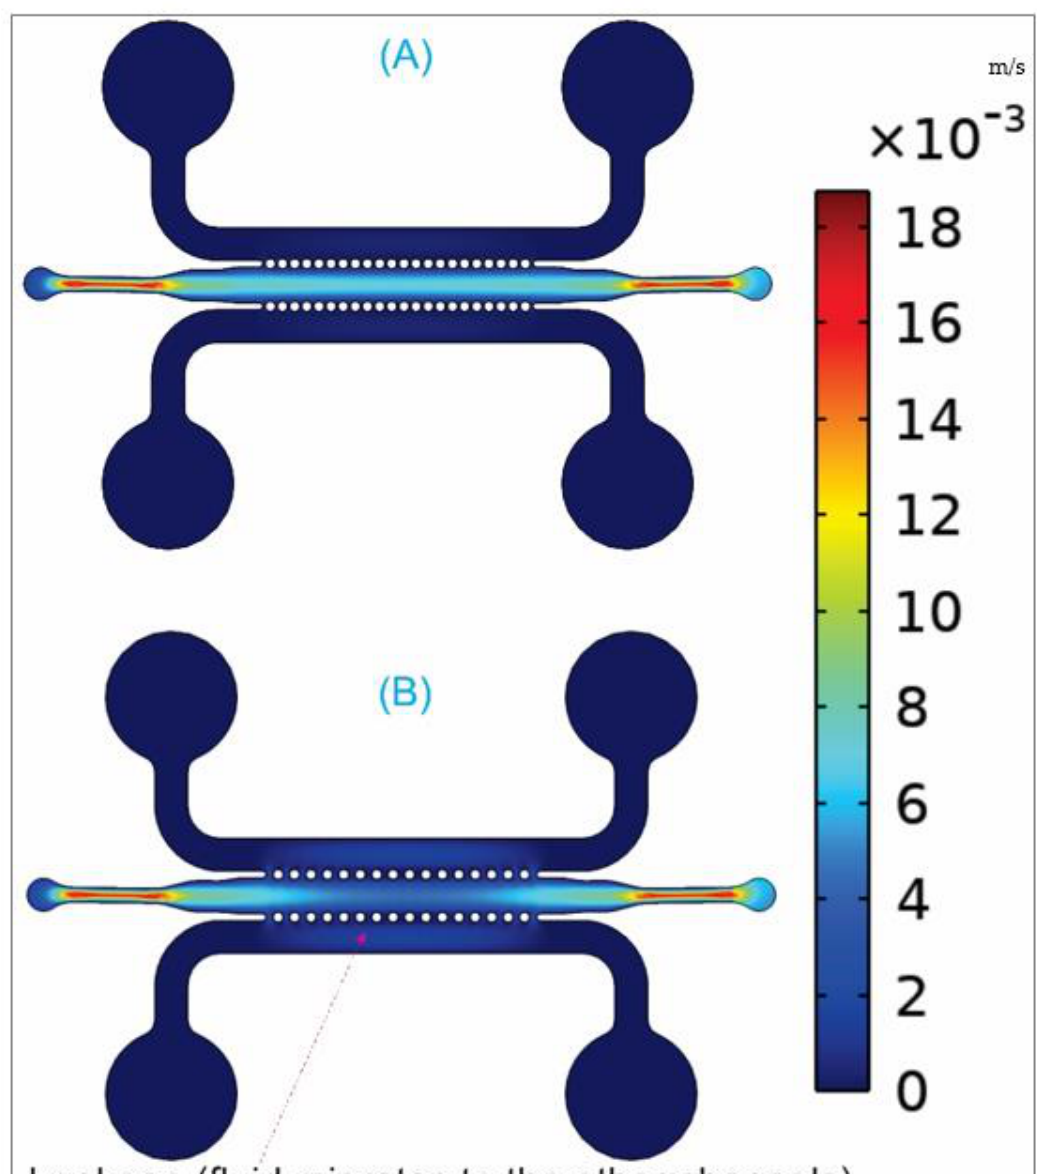
Figure 6. COMSOL simulation results showing the effect of spacing distance in controlling fluid leakage. Leakage does not occur at a small spacing distance ( A ) 70 µ m, but at a large spacing distance leakage. Leakage does not occur at a small spacing distance ( A ) 70 μ m, but at a large spacing dis- ( B ), 200 µ tance ( B ), 200 µm.